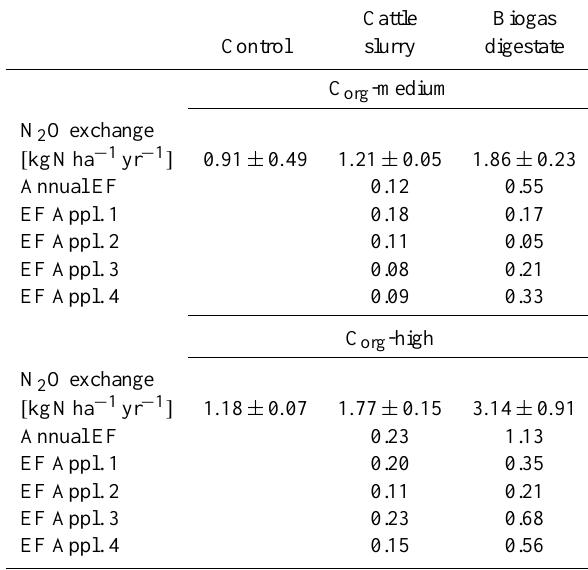
Table 5. Calculated EFs for the year 2011 and for single application events (16 days; Appl. 1–Appl. 4). The EF is based on the amount of total nitrogen (N tot ) without consideration of NH 3 –N